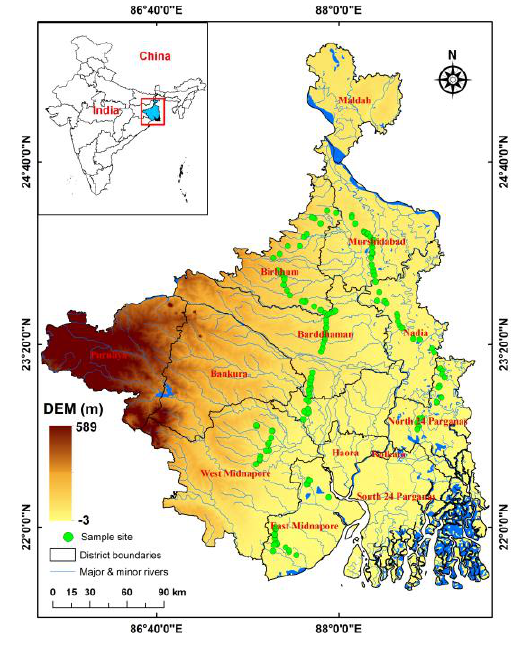
Figure 1. Physical setup of the study